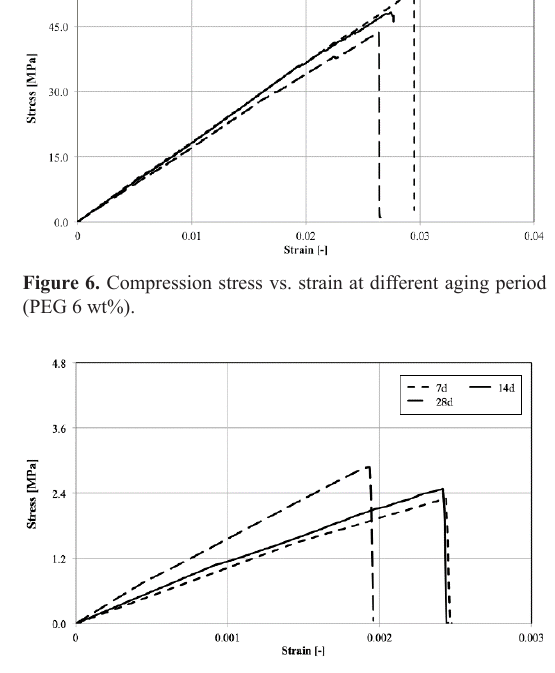
Figure 7. Bending stress vs. strain at different aging period (PEG 6 wt%).